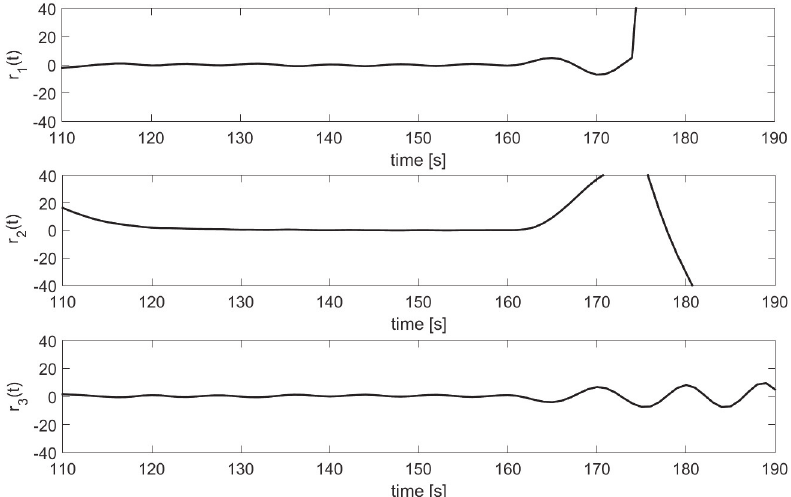
Figure 13. Response of residual to the actuator fault f a 2 .